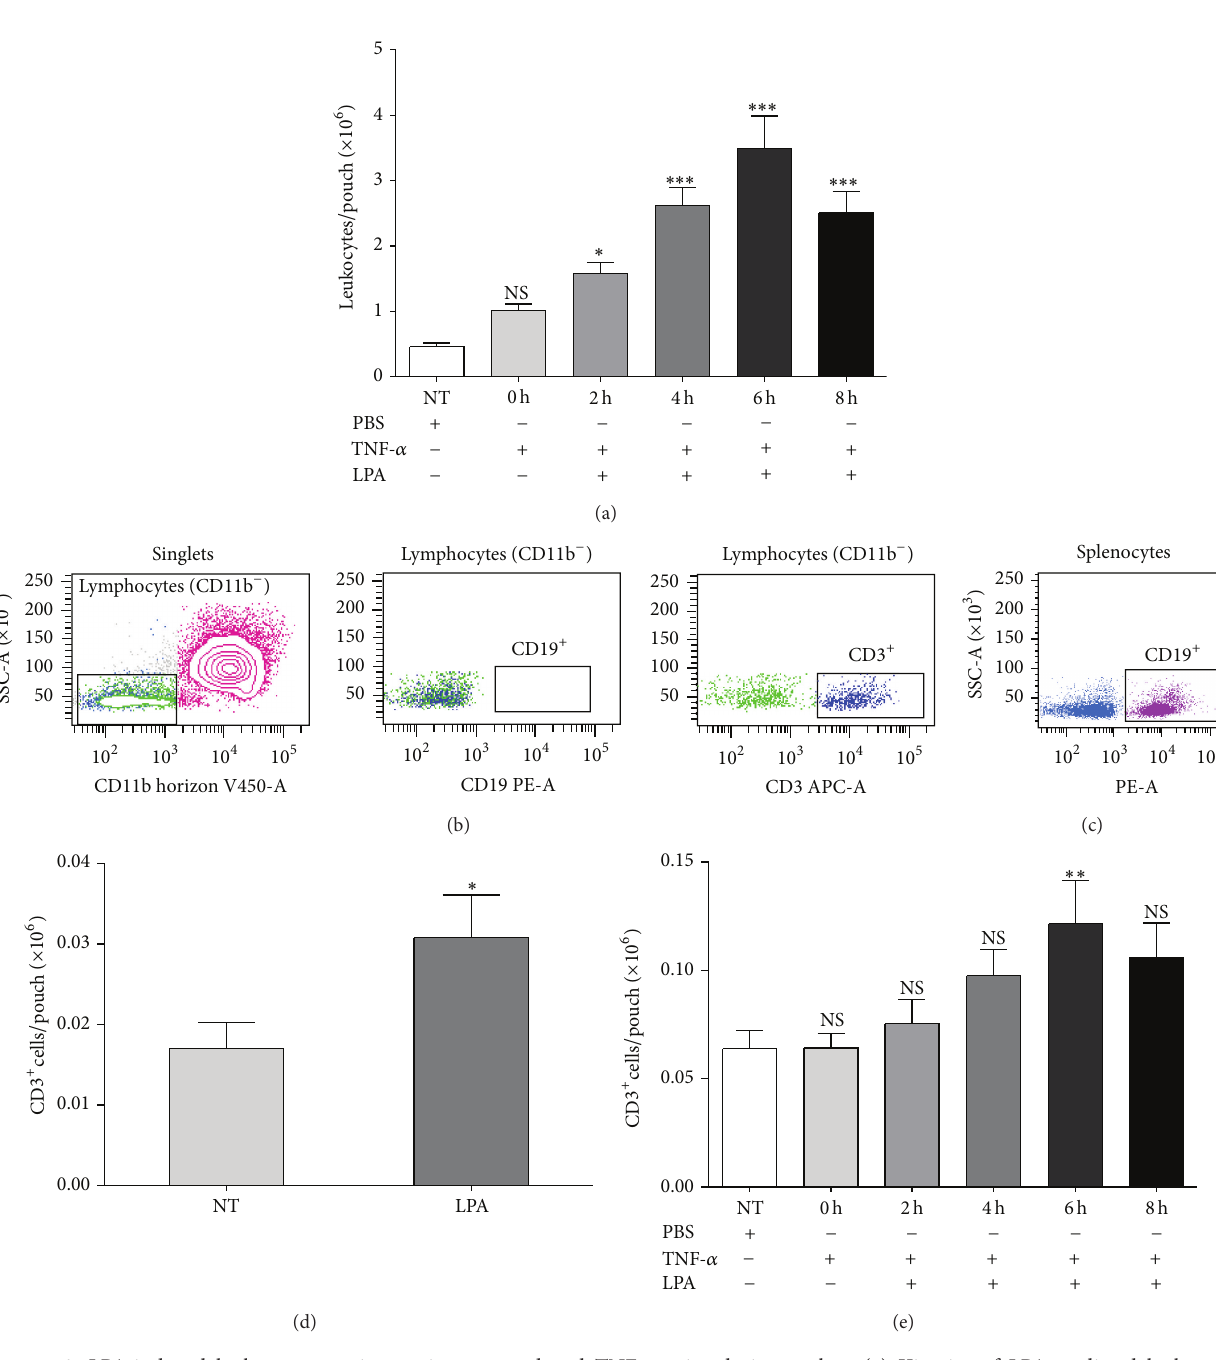
Figure 3: LPA-induced leukocyte recruitment in untreated and TNF- 𝛼 -primed air pouches. (a) Kinetics of LPA-mediated leukocyte recruitment into TNF- 𝛼 -treated air pouches. TNF- 𝛼 (50 ng) was injected into the air pouches 16 h prior to stimulation with 3 𝜇 g LPA for the indicated times. Air pouch exudates were collected and the number of leukocytes was determined as described in Section 2. (b) Leukocyte populations in lavage fluids collected from air pouches pretreated with TNF- 𝛼 for 16h and injected with LPA for 6 h. Cells were stained with various leukocyte markers and analyzed by flow cytometry. The CD11b − cells were defined as lymphocytes according to their low granularity (left panel), which stained positive for CD3 (T cells, right panel) or CD19 (B cells, middle panel). (c) Labelling of B cells isolated from mouse spleen. Splenocytes were prepared as described in Section 2 and used for titration of anti-CD3e and anti-CD19 antibodies. (d) LPA-induced CD3 + cell recruitment into the air pouches. Air pouch exudates were collected at 6 h after LPA injection. The total number of leukocytes was measured and that of T cells determined by flow cytometry. (e) The absolute numbers of CD3 + cells recruited by LPA into TNF- 𝛼 -primed air pouches was evaluated as described in (d). Data are the mean ± SE from 6 mice/group. ∗ 𝑃 < 0.05 , ∗∗ 𝑃 < 0.01 , and ∗∗∗ 𝑃 < 0.001 by analysis of variance. SSC: side scatter; FSC: forward